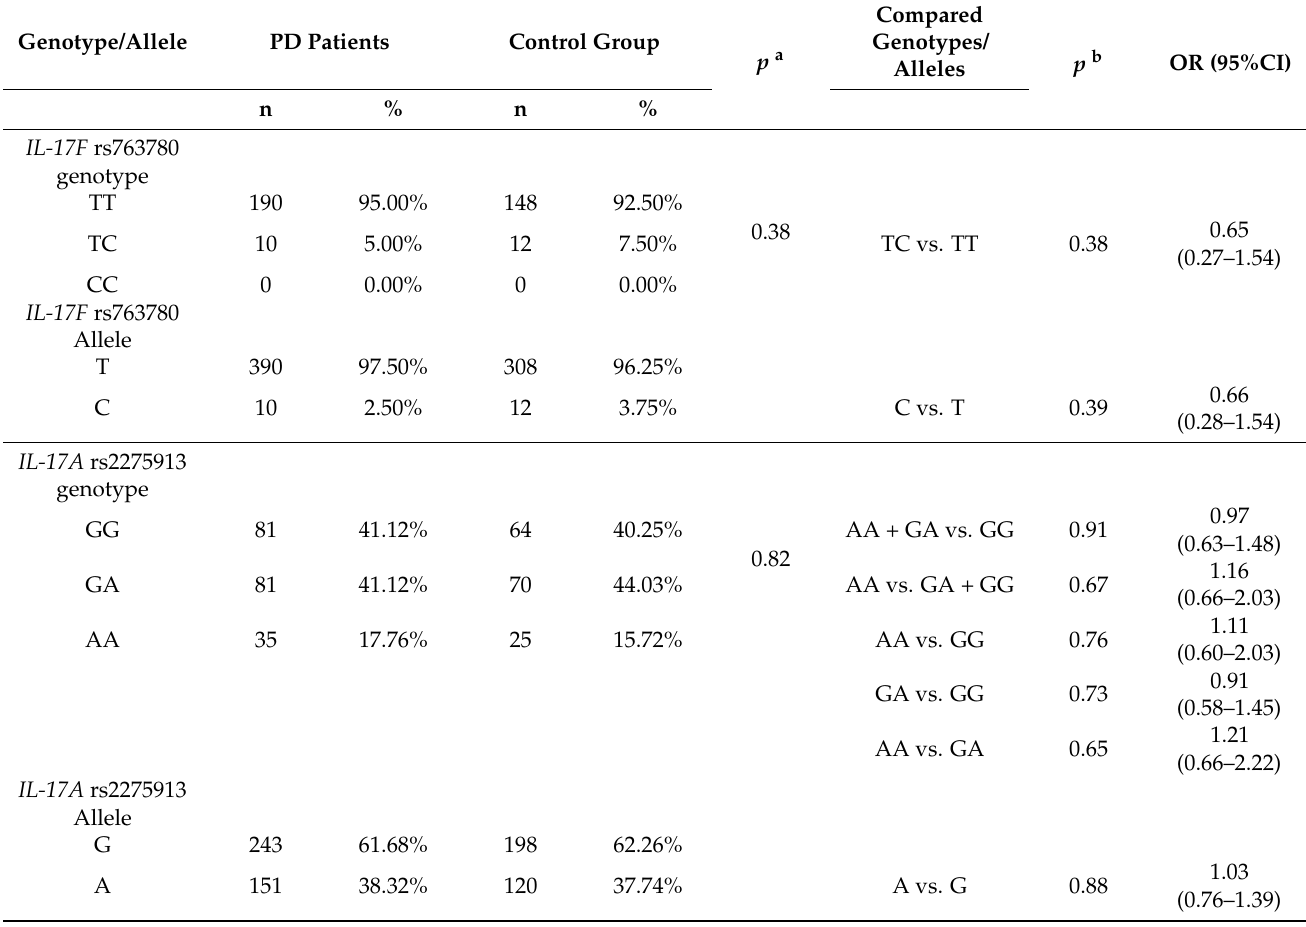
Table 2. The distribution of IL-17F rs763780 and IL-17A rs2275913 genotypes in periodontitis patients and control group.